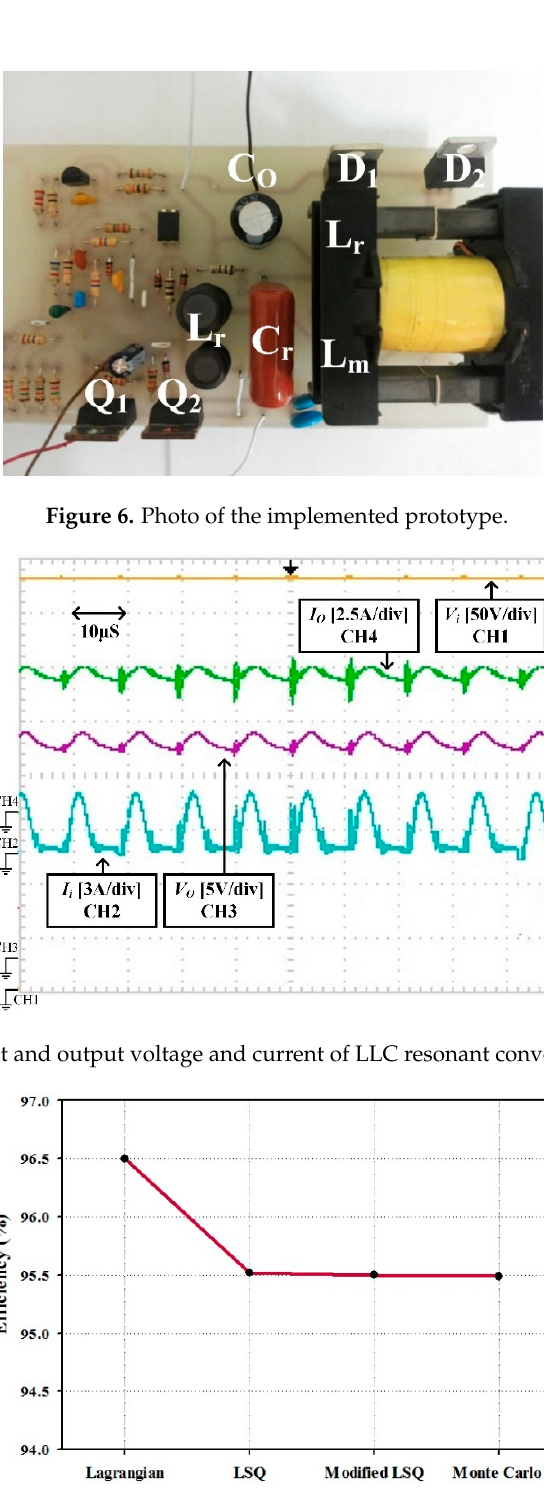
Figure 8. Measured optimized efficiency of the implemented prototype .